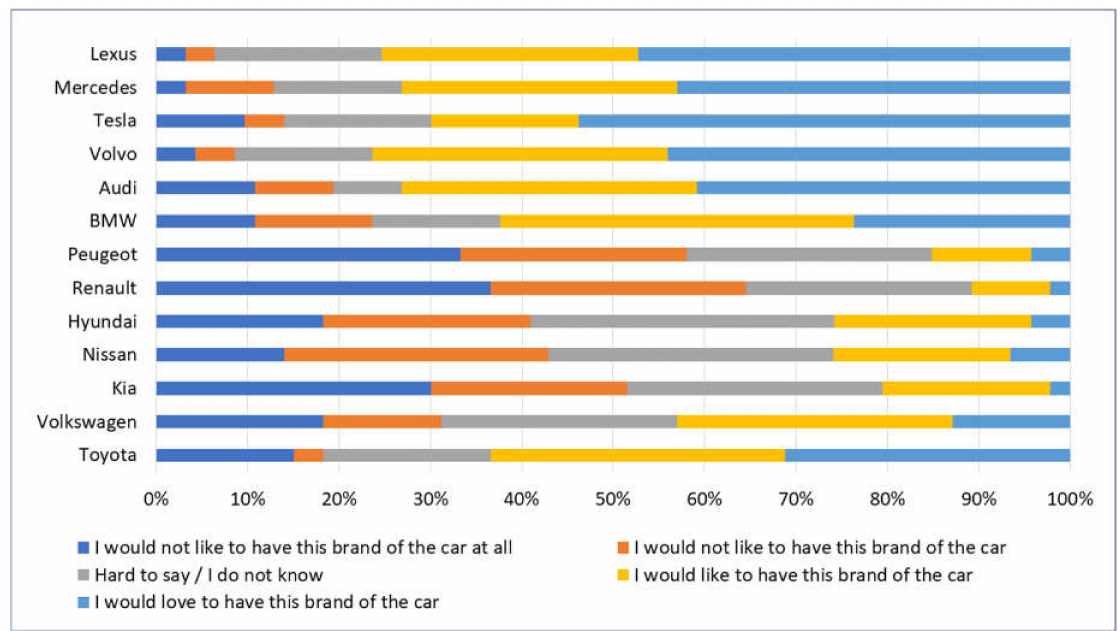
Figure 8. Assessment of the importance of the respondents’ preferences as to the brand of potentially purchased AFV (N =